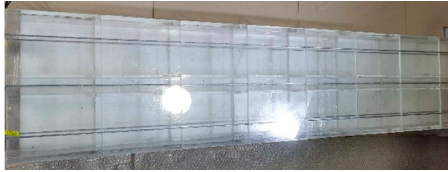
Figure 5: Pipe joint model. Table 2: Soil parameter of model